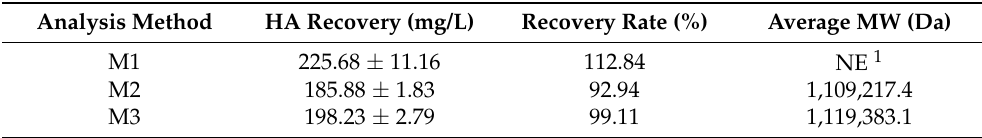
Table 3. Recovery of HA with the different methods proposed.